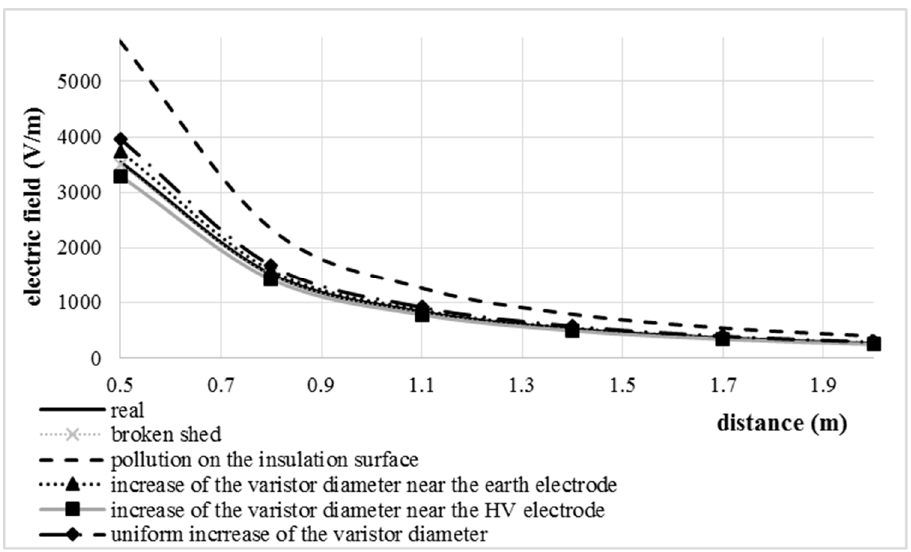
Figure 16. Electric field (V/m) in function with the distance from the arrester (height from the earth electrode equal to 21 cm). Energies 2018 , 11 , x FOR PEER REVIEW